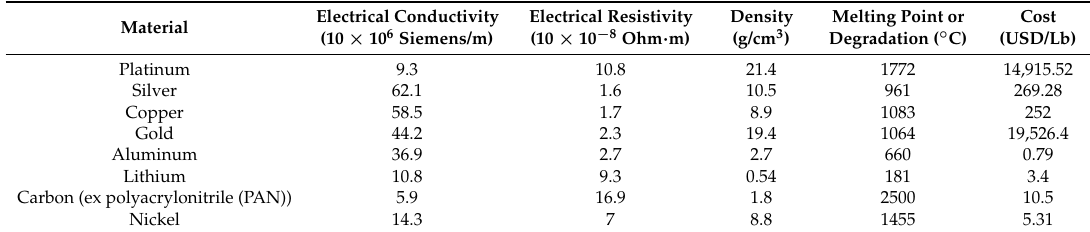
Table 1. Physical properties of popular electrode